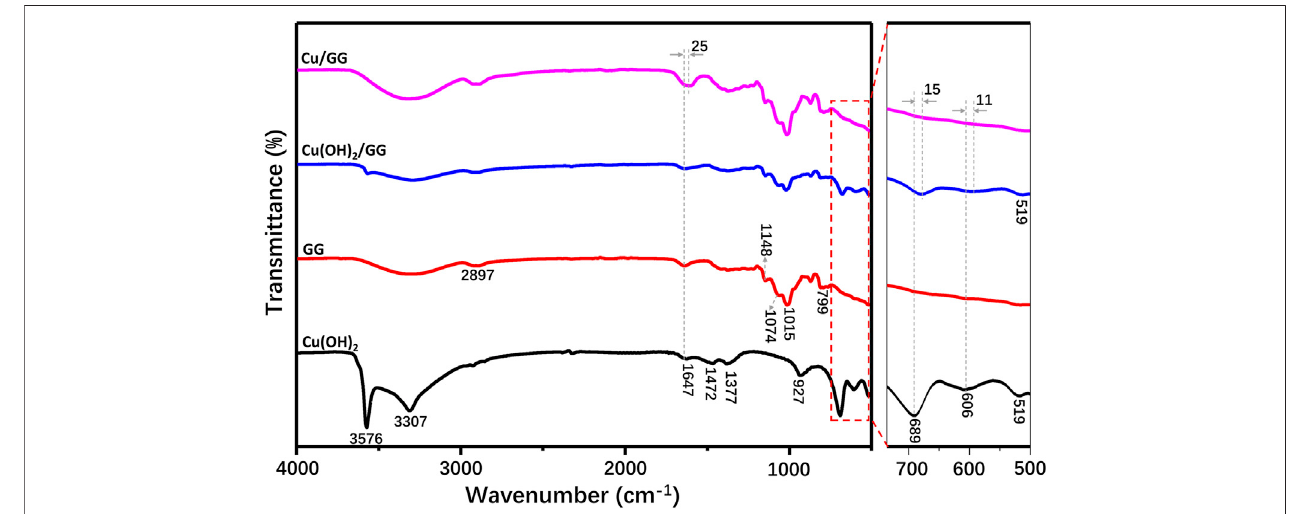
FIGURE 4 | FTIR spectroscopy of Cu/GG, Cu(OH) 2 /GG, GG and Cu(OH) 2 .